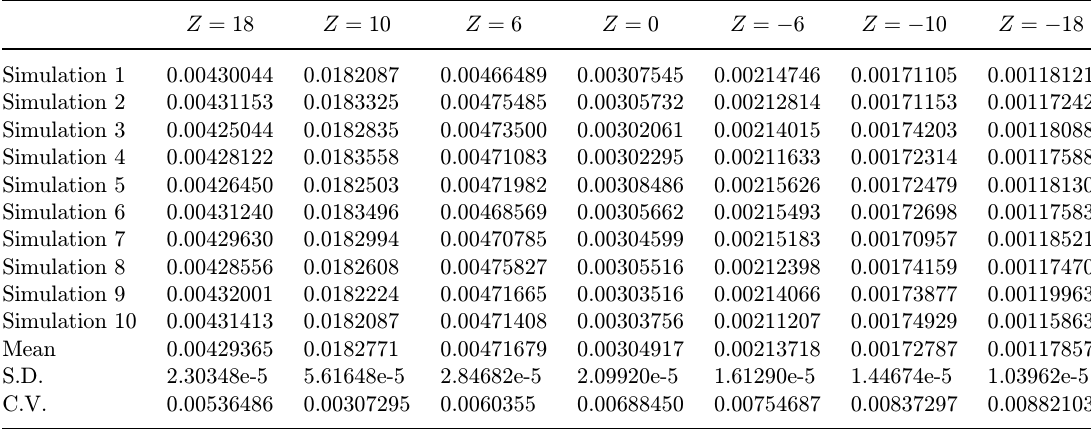
Table 5. Repeated simulation